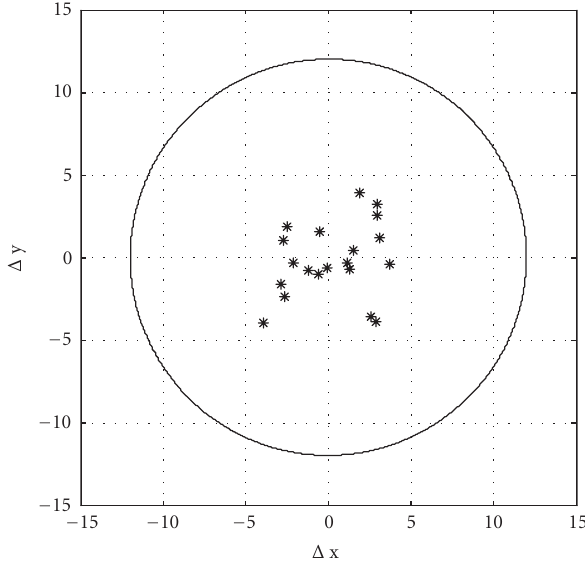
Figure 7: Numerical results for the proposed location position sys- tem based on watermark